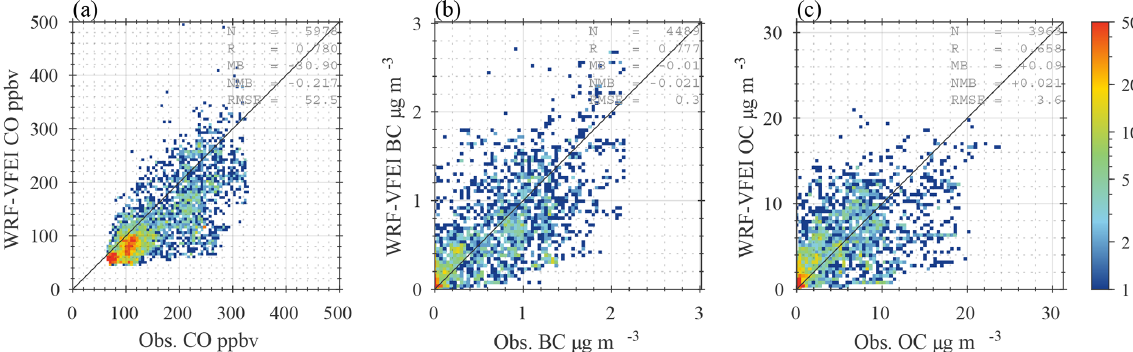
Figure 11. Scatter plots displayed as heat maps comparing the airborne data from the ORACLES-2016 campaign in Southern Africa and the WRF-VFEI simulations. (a) Carbon monoxide (in ppb), (b) black carbon (in µgm − 3 ), and (c) organic carbon (in µgm − 3 ). Statistics are reported in each panel, such as the number of points ( N ), correlation ( R ), mean bias (MB), normalized mean bias (NMB), and root mean squared error